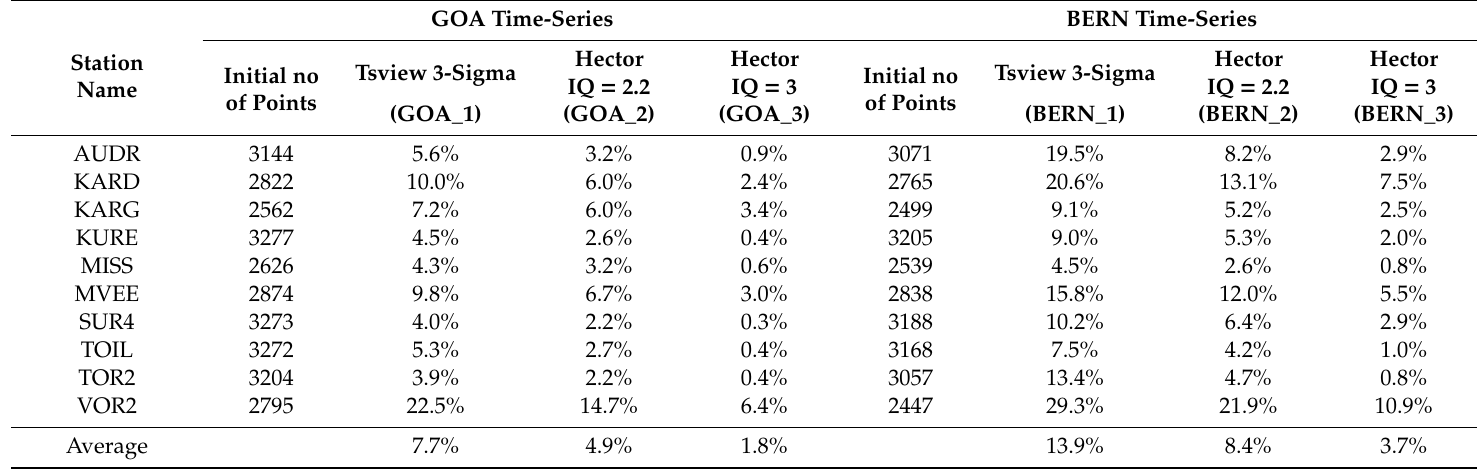
Table 2. Amount on the detected outliers (North, East, and Up (NEU) component together) in GOA and BERN time-series using di ff erent criteria.